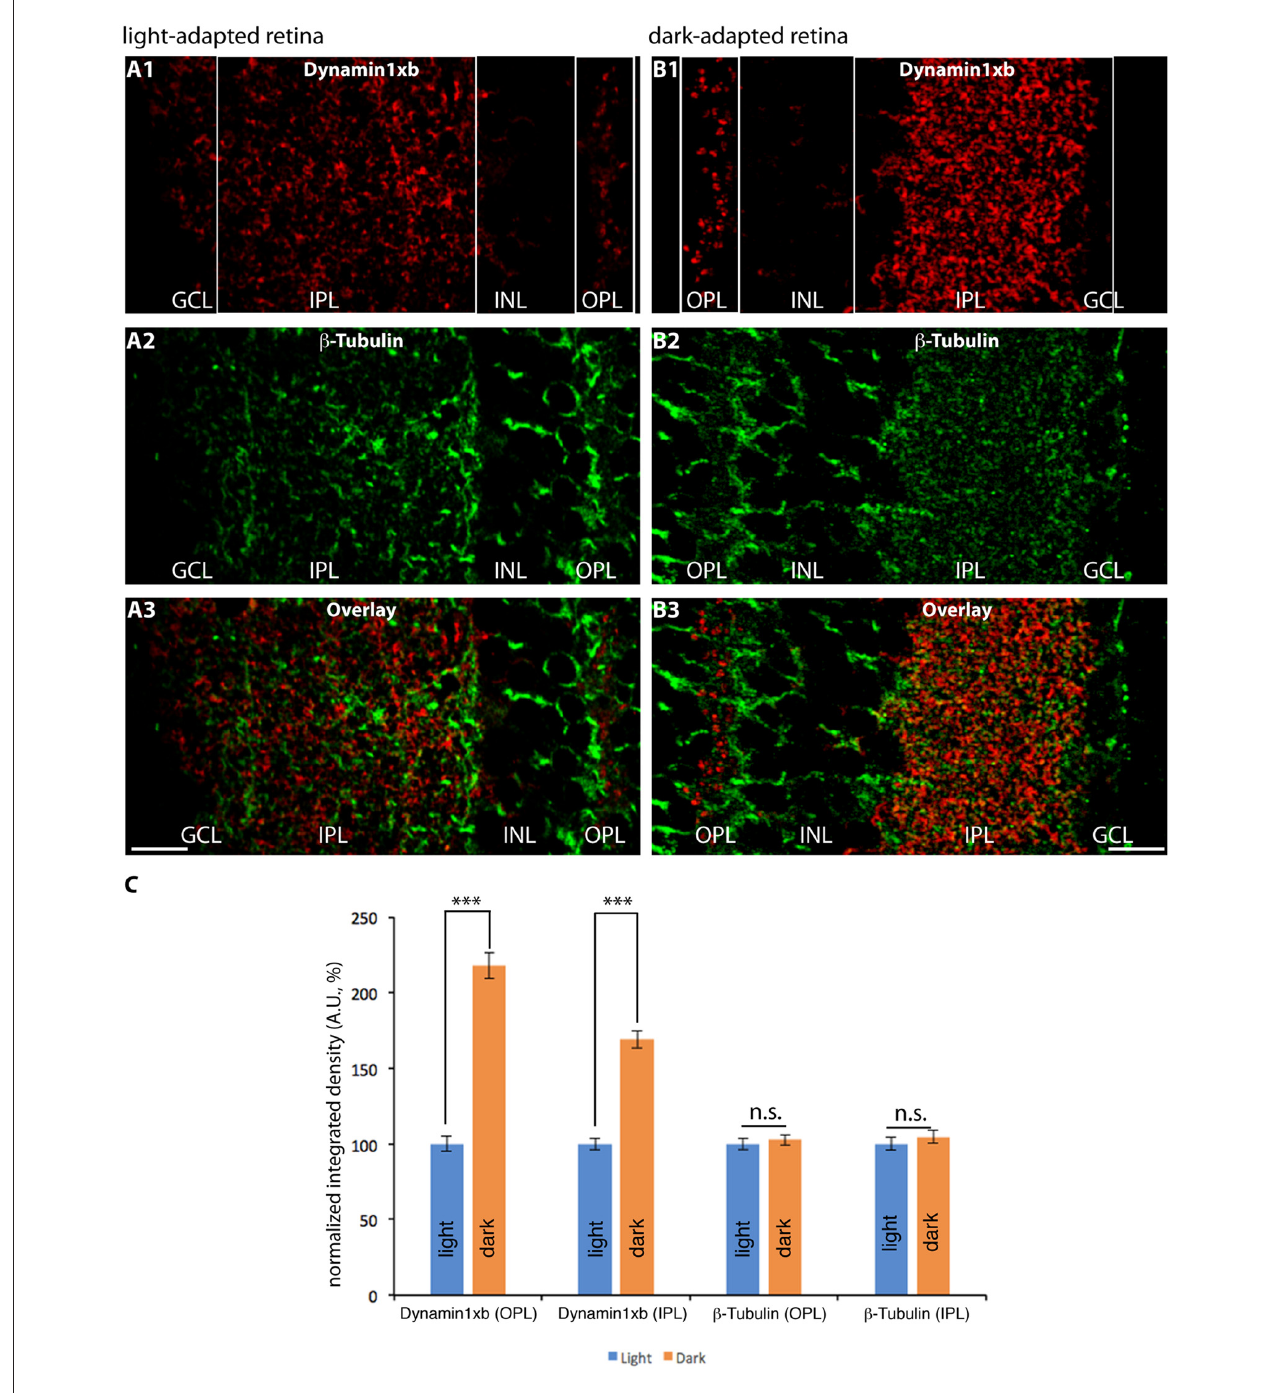
FIGURE 9 | Semi-thin (1.5 µ m-thin) sections of light- (A) and dark- (B) adapted retinas double-immunolabeled with antibodies against dynamin1xb (A1,3 ; B1,3) and β -tubulin (A2,3 ; B2,3) . As shown above (Figures 3 , 4) , the dynamin1xb immunosignal was enriched in the synaptic layers of the retina, the OPL and IPL. In the dark-adapted condition, we observed an enhanced dynamin1xb immunosignal in the synaptic layers of the OPL and IPL, while the β -tubulin immunosignal in the synaptic layers was unchanged. The boxed regions (white boxes) indicate the regions of interest, i.e., OPL and IPL, used for the quantification of immunofluorescence (IF) signals. (A,B) were obtained by confocal microscopy. (C) Quantification of the immunosignals in the OPL and IPL for dynamin1xb and β -tubulin (normalized data). Quantification of IF signals (detemined as integrated density) was done as previously described (Wahl et al., 2016). N = 3 embeddings for light- and dark-adapted retinas; n = 97 images analyzed for both light-and dark-adapted retinas. Error bars are SEM. Abbreviations: A.U, arbitrary units; OPL, outer plexiform layer; INL, inner nuclear layer; IPL, inner plexiform layer; GCL, ganglion cell layer. ∗∗∗ p < 0.001; n.s., non significant. Scale bars: 20 µ m.